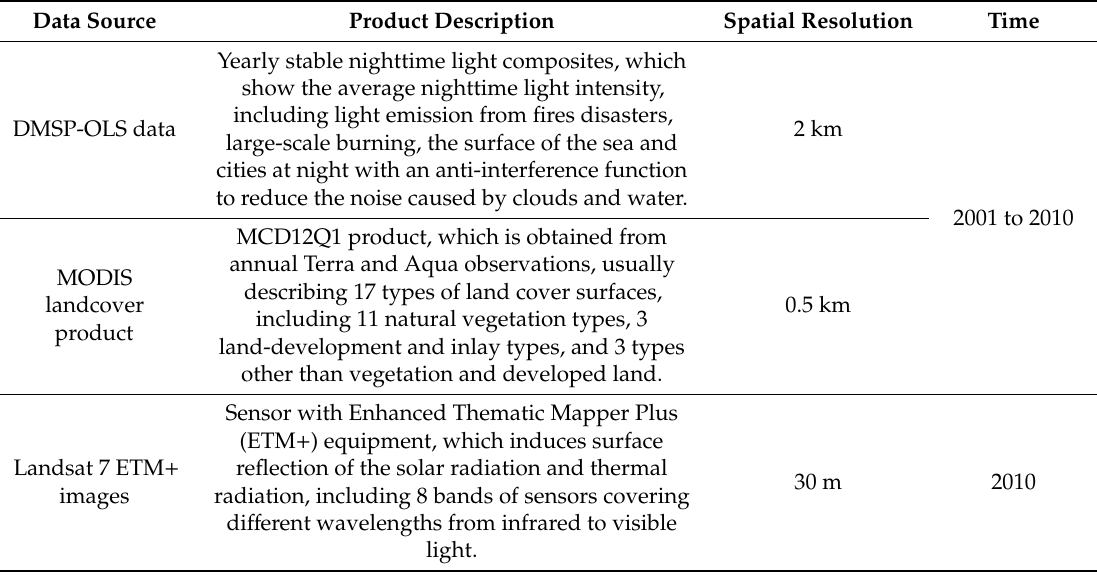
Table 1. Description of the Multisource remote sensing data sets used in this